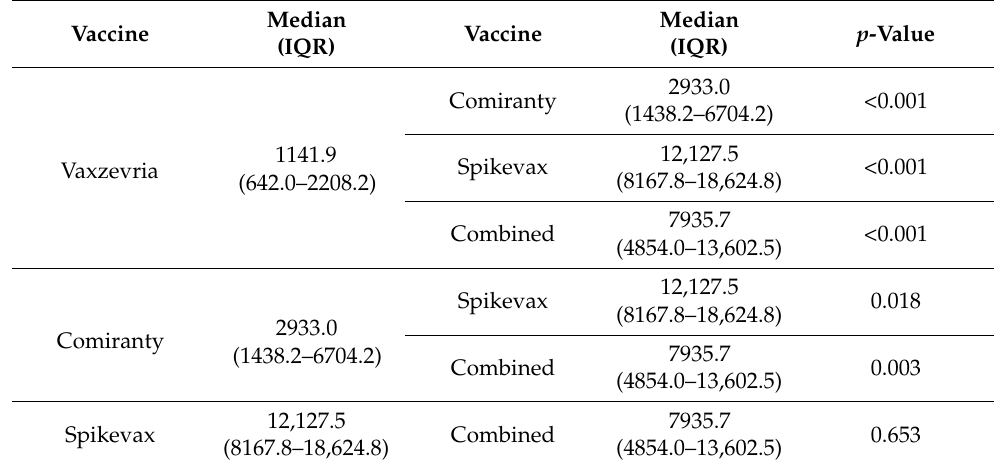
Table 4. Multiple comparisons by Bonferroni method for the antibody titer among different types of